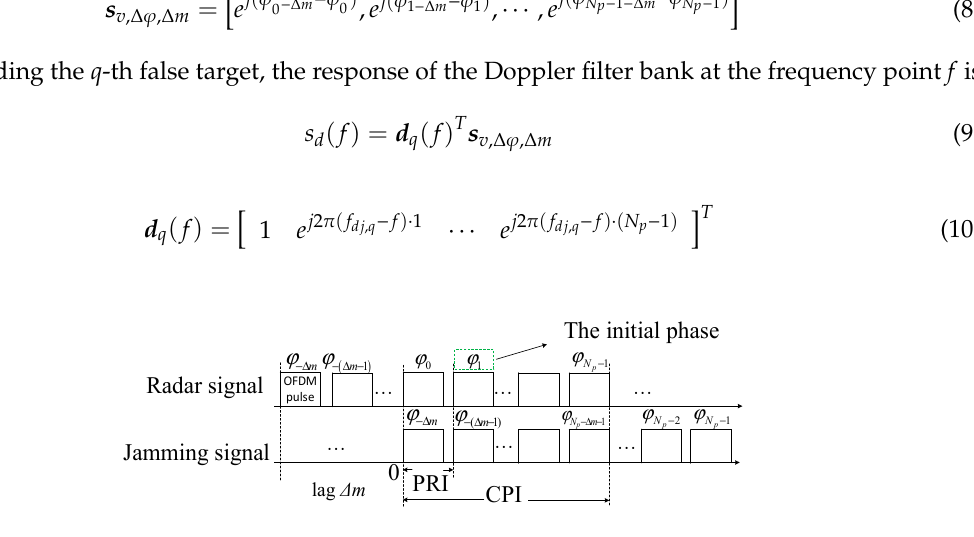
Figure 2. ECCM scheme of resisting the VDJ with lag Δ m .